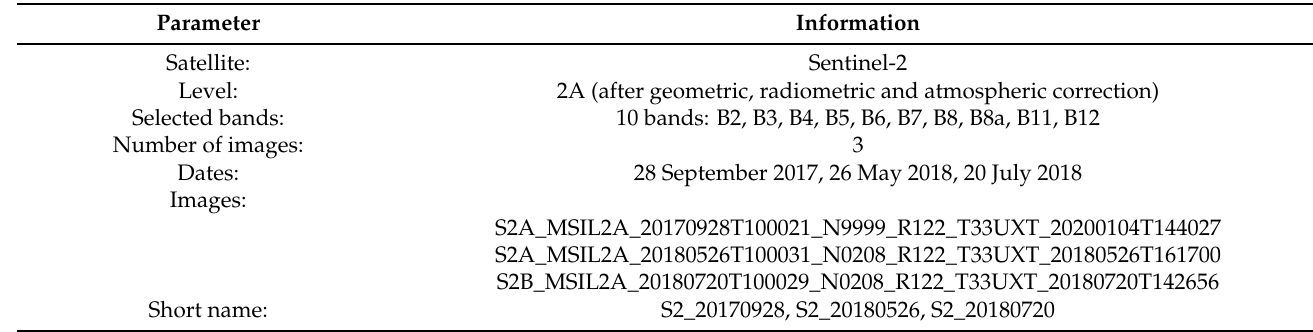
Table 2. Characteristics of the Sentinel-2 satellite images.